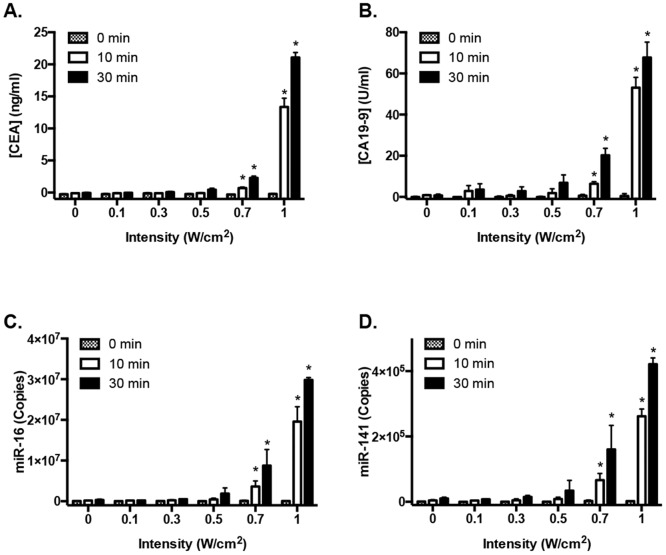
Release of biomarkers from LS174T cells in culture treated with varying ultrasound intensities.Cells in culture (n = 2 wells) were exposed to varying ultrasound intensities (0, 0.1, 0.3, 0.5, 0.7 and 1.0 W/cm2) at 1 MHz and 10% duty cycle. The biomarker levels were studied in the media and were seen to progressively increase with an increase in intensity as well as an increase in time (0, 10, 30 min). There was a significant (*p≤0.05) increase in CEA (A), CA19-9 (B), miR-16 (C) and miR-141 (D) at 0.7 and 1 W/cm2 for 10 and 30 min of treatment. Error bars are SD.